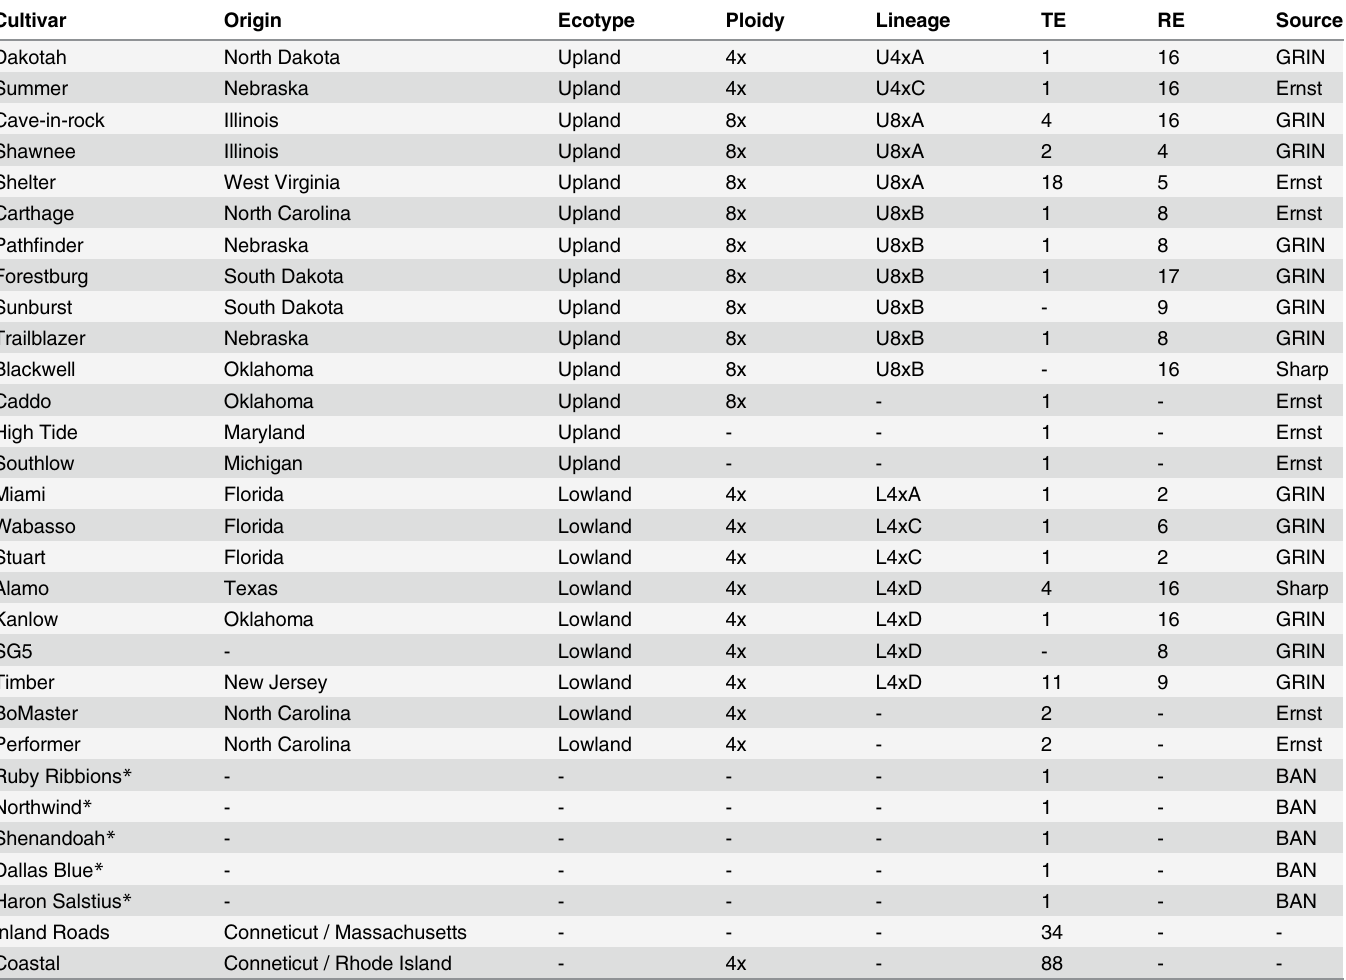
Table 1. Switchgrass accessions in the reference dataset.